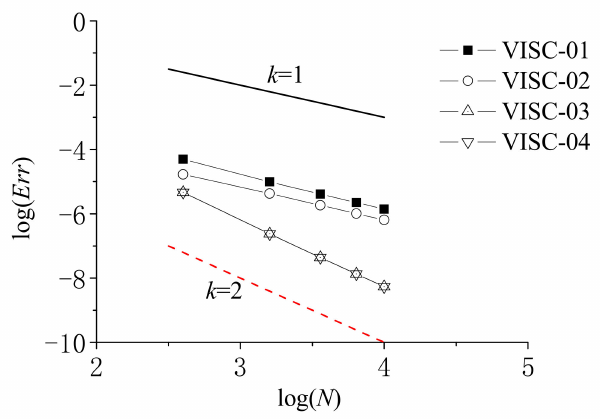
Figure 3. Convergence and error analysis of different viscosity force models under the uniform particle distribution.